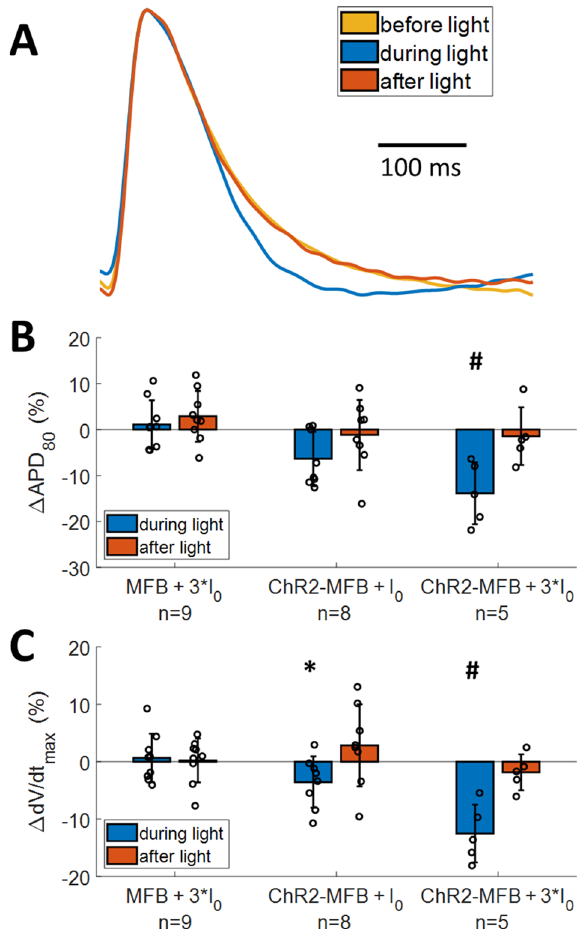
Figure 4. Inward current in myofibroblasts changes action potential (AP) characteristics in co-cultured myofibroblast syncytia. ( A ) Averaged AP trace before (gold), during (blue), and after (orange) application of 3*I 0 blue light to activate ChR2 current in ChR2-MFBs. ( B-C ) Percent change (from value prior to light application) in action potential duration (APD 80 , B ) and maximal upstroke rate (dV/dt, C ) during and after application of light at different power levels during 500 ms CL pacing, for co-cultures of CMs with MFBs or ChR2-MFBs. * indicates p < 0.05, # indicates p < 0.005 between ChR2-MFB and MFB co-culture responses during light.